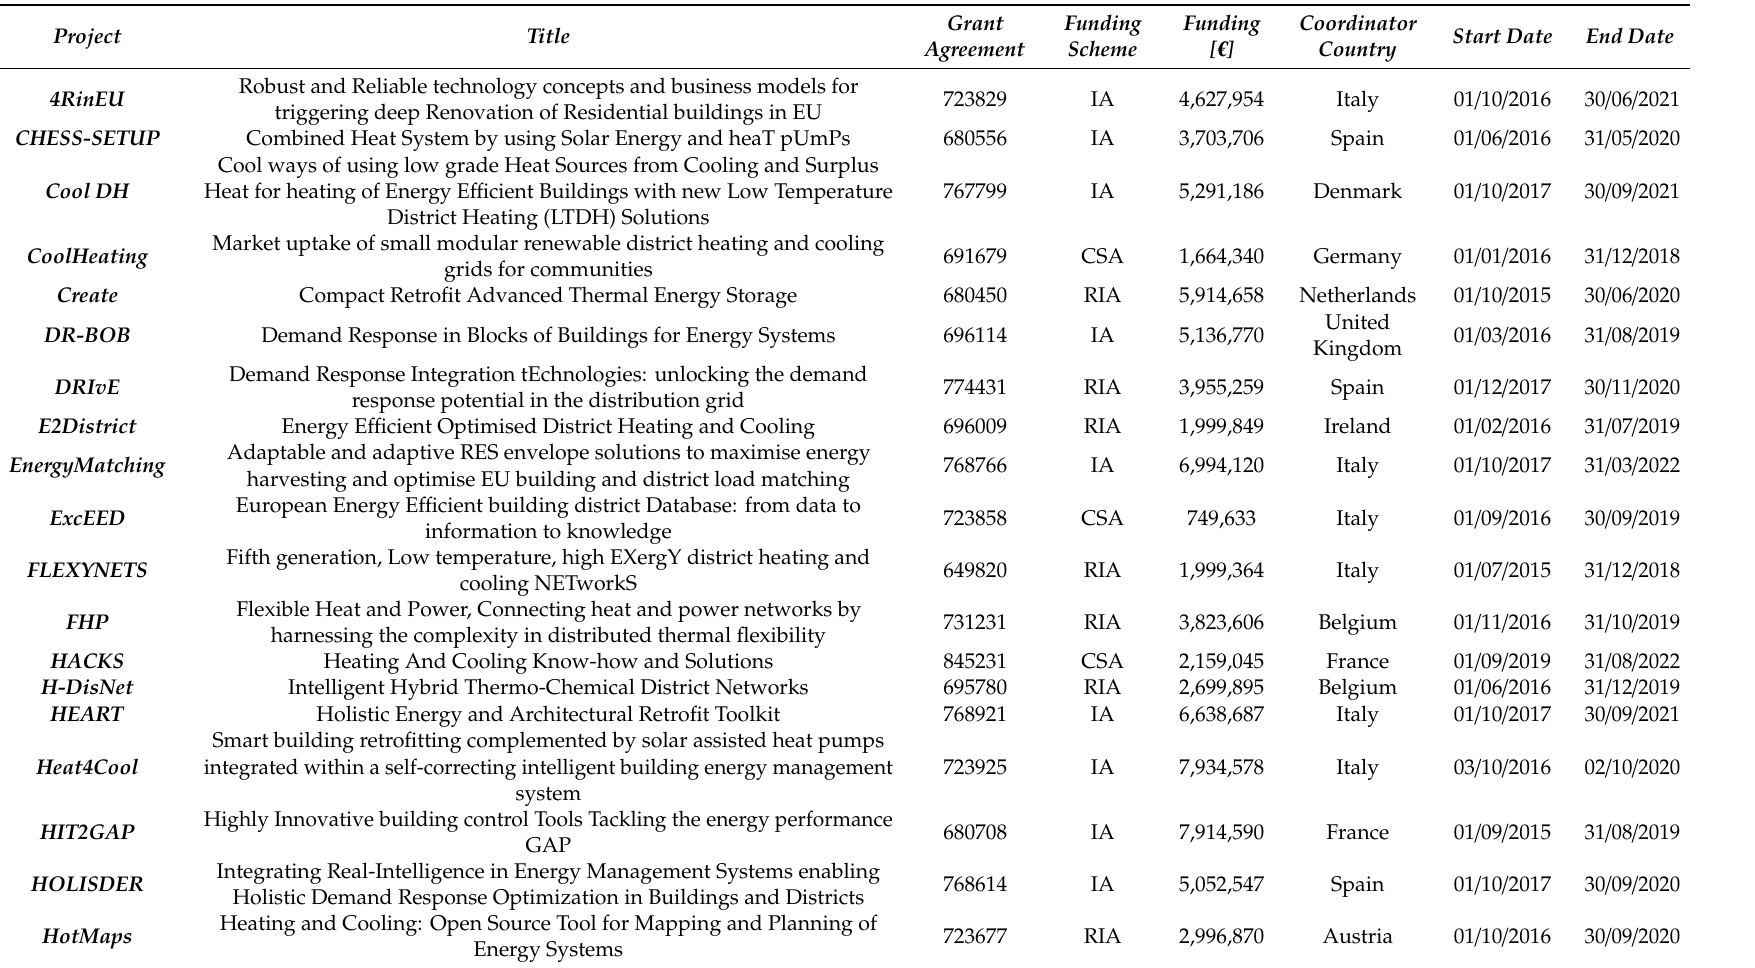
Table A1. General information of the selected projects funded by the Horizon 2020 Framework